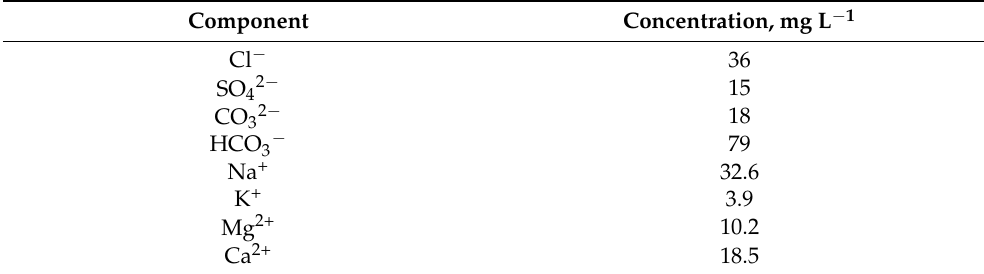
Table 1. Composition of the model water solution.